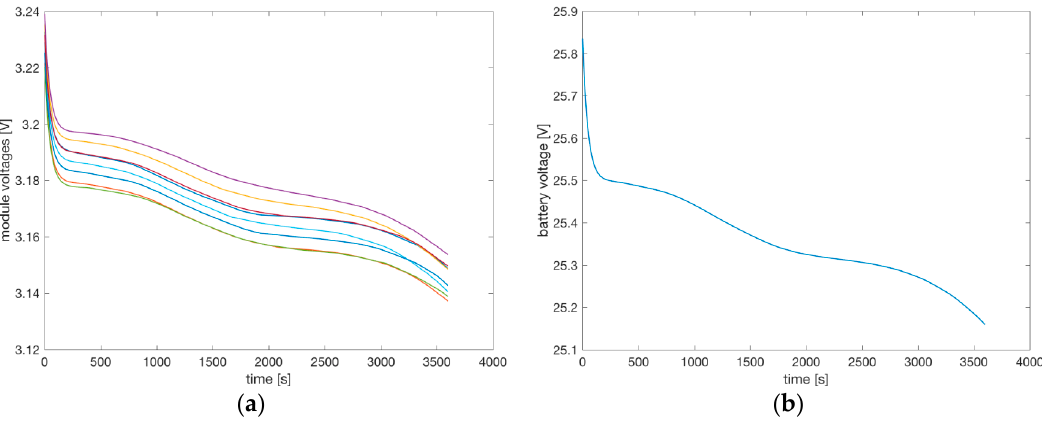
Figure 13. ( a ) Output voltage of the eight packs connected in series; ( b ) voltage of the complete battery.